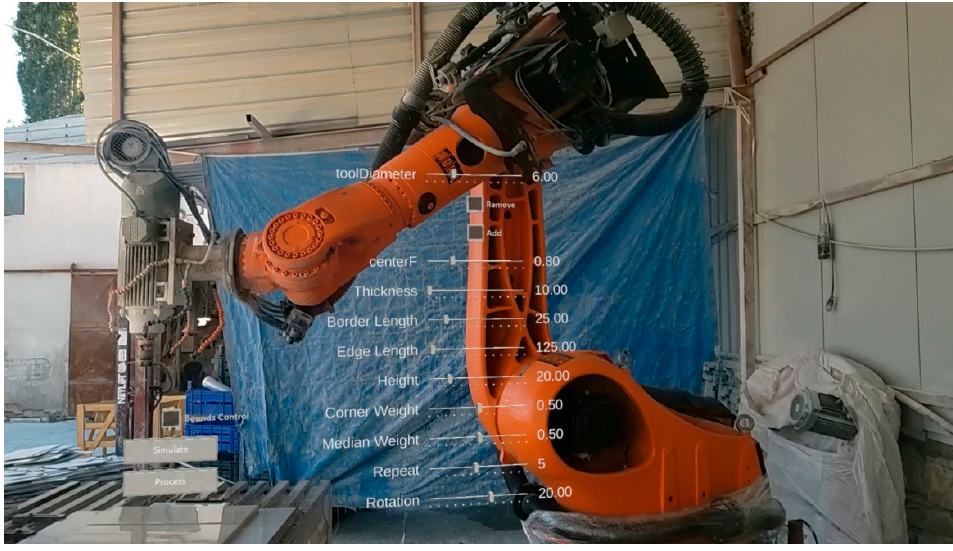
Figure 15. The user can access and change the parametric-design and robotic-fabrication parameters using the mixed-reality device.